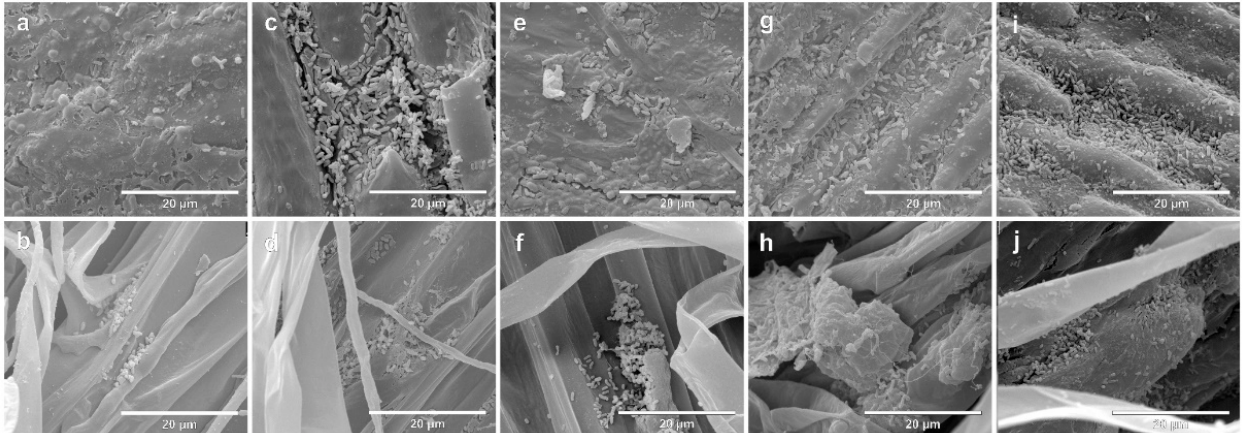
Figure 3. Scanning electron micrographs of seeds and rootlets of Megathyrsus maximus cultivar Zuri, colonized by Azospirillum brasilense (CNPSo 2083 + CNPSo 2084) , Bacillus subtillis (CNPSo 2657), Pseudomonas fluorescens (CNPSo 2719), or Rhizobium tropici (CNPSo 103), after 7 days of growth. Non-inoculated seeds ( a ) and rootlets ( b ); seeds ( c ) and rootlets ( d ) of plants inoculated with A. brasilense ; seeds ( e ) and rootlets ( f ) of plants inoculated with B. subtilis ; seeds ( g ) and rootlets ( h ) of plants inoculated with P. fluorescens ; seeds ( i ) and rootlets ( j ) of plants inoculated with R. tropici .